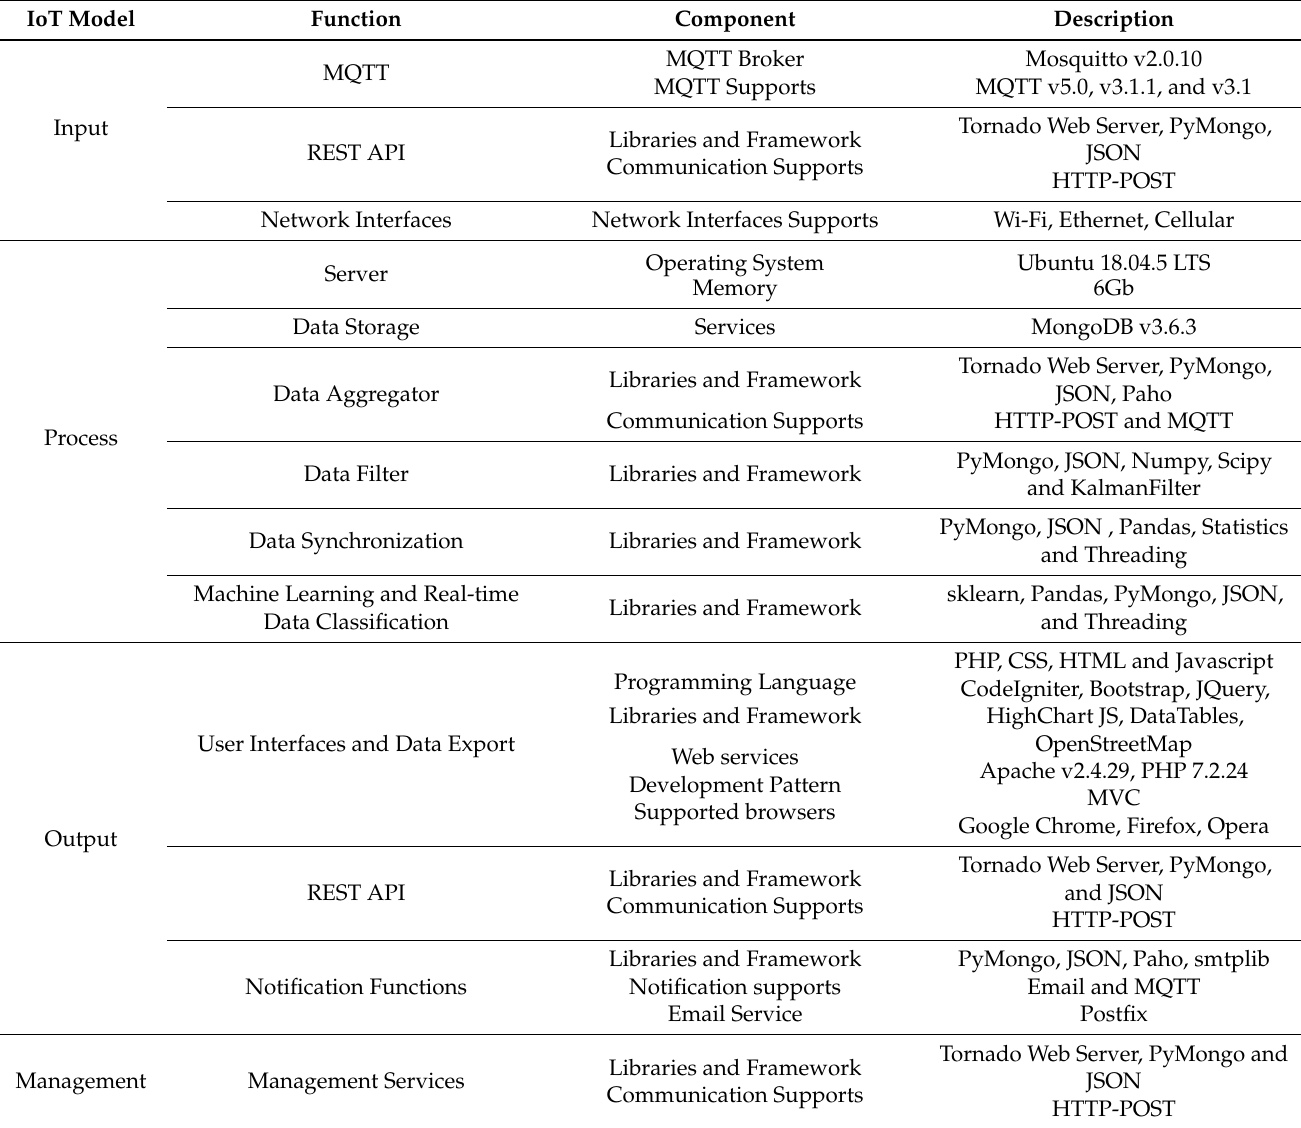
Table 2. Technology specifications for implementation of SEMAR IoT server